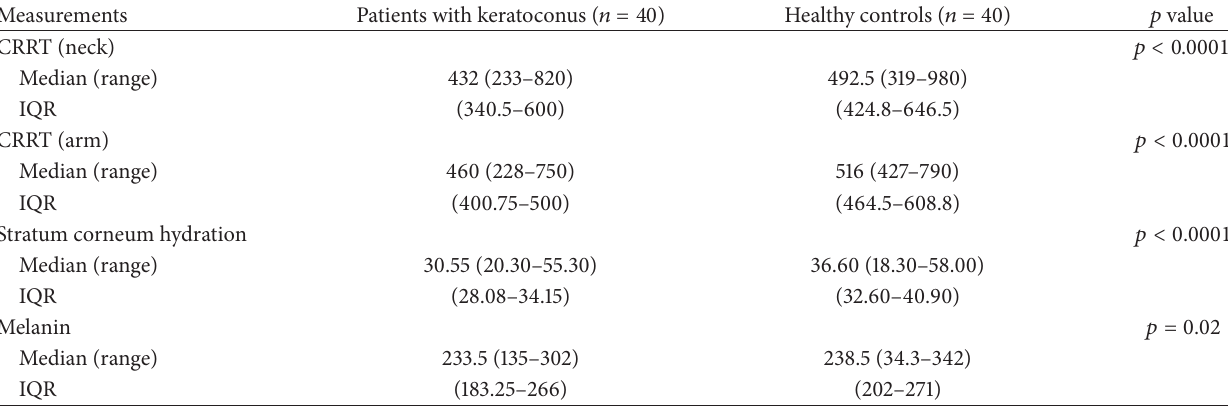
Table 1: CRRT, stratum corneum hydration, and melanin measurements in patients with keratoconus and healthy controls.